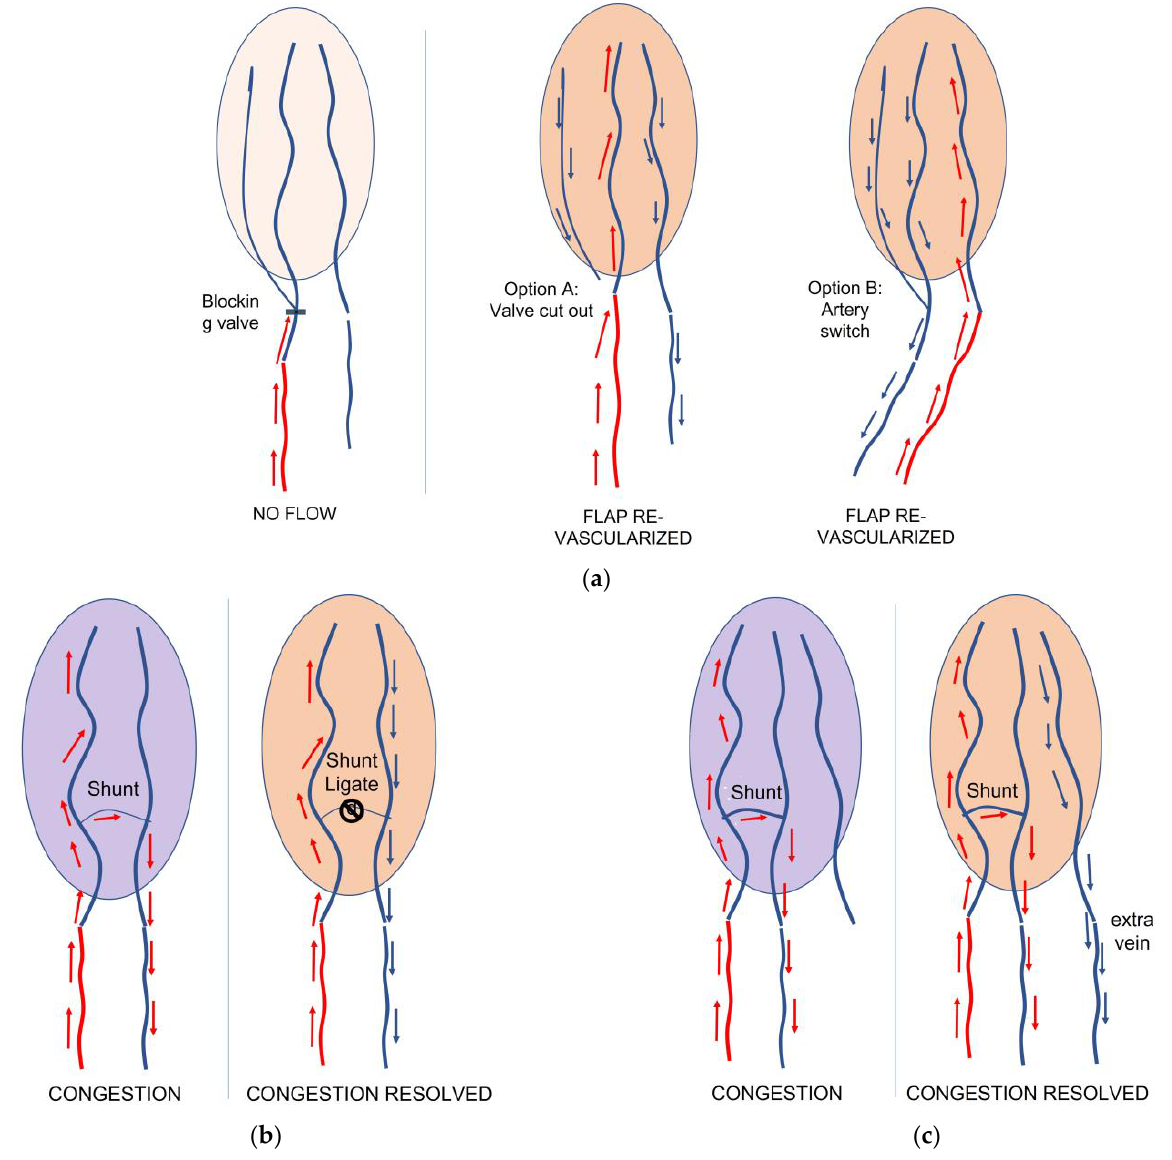
Figure 3. ( a ) In case of insufficient revascularization of the flap, a blocking valve before the flap can be the cause; accordingly, we suggest performing a more distal anastomosis to the same or to a different vein. Otherwise, we suggest switching the arterialized vein with the draining one as an alternative. ( b ) In case of congestion due to an Artero-Venous (AV) shunt, ligature is